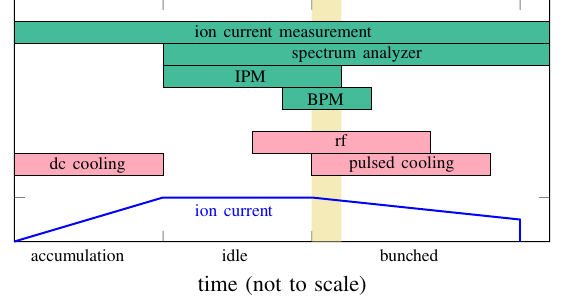
FIG. 5. Sketch of the top-level timing of beam instrumentation components. Components manipulating the beam are shown in red, components measuring its properties in green. The yellow band denotes the time window of interest in which the pulsed cooling process can be observed in all dimensions.